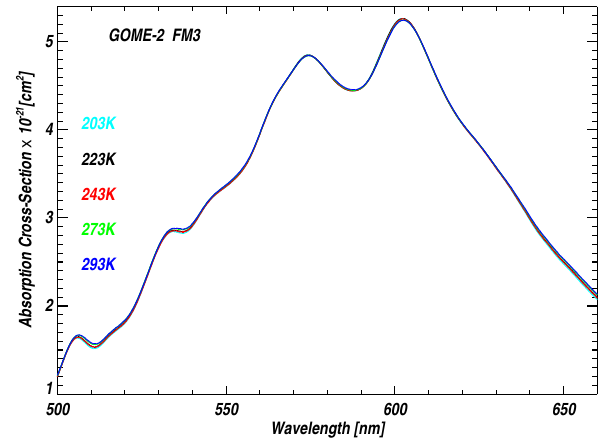
Fig. 3. GOME-2 FM3 temperature dependent absorption cross sec- tion spectra in the Huggins band. The temperature dependence is strong, the cross sections decrease with decreasing temperature.